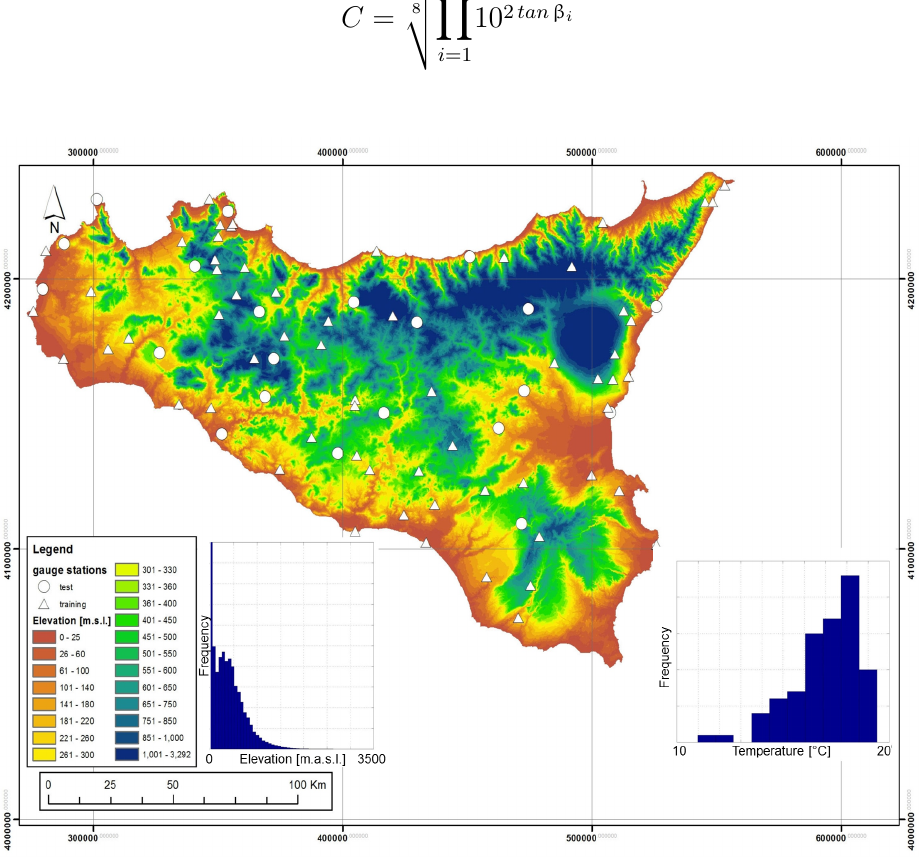
Figure 1. One hundred-meter DEM of Sicily; elevation histograms, based on DEM, and average mean temperature histogram, based on station records, are reported next to the legend and on the bottom-right,